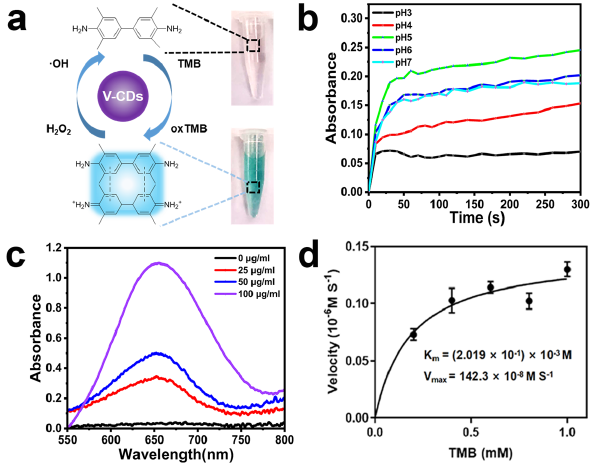
Figure 3. ( a ) Schematic illustration of TMB used to detect OH produced by V − CDs catalytic H 2 O 2 . ( b ) Catalytic activity of V − CDs for TMB oxidation at various pH values. ( c ) Absorption spectra